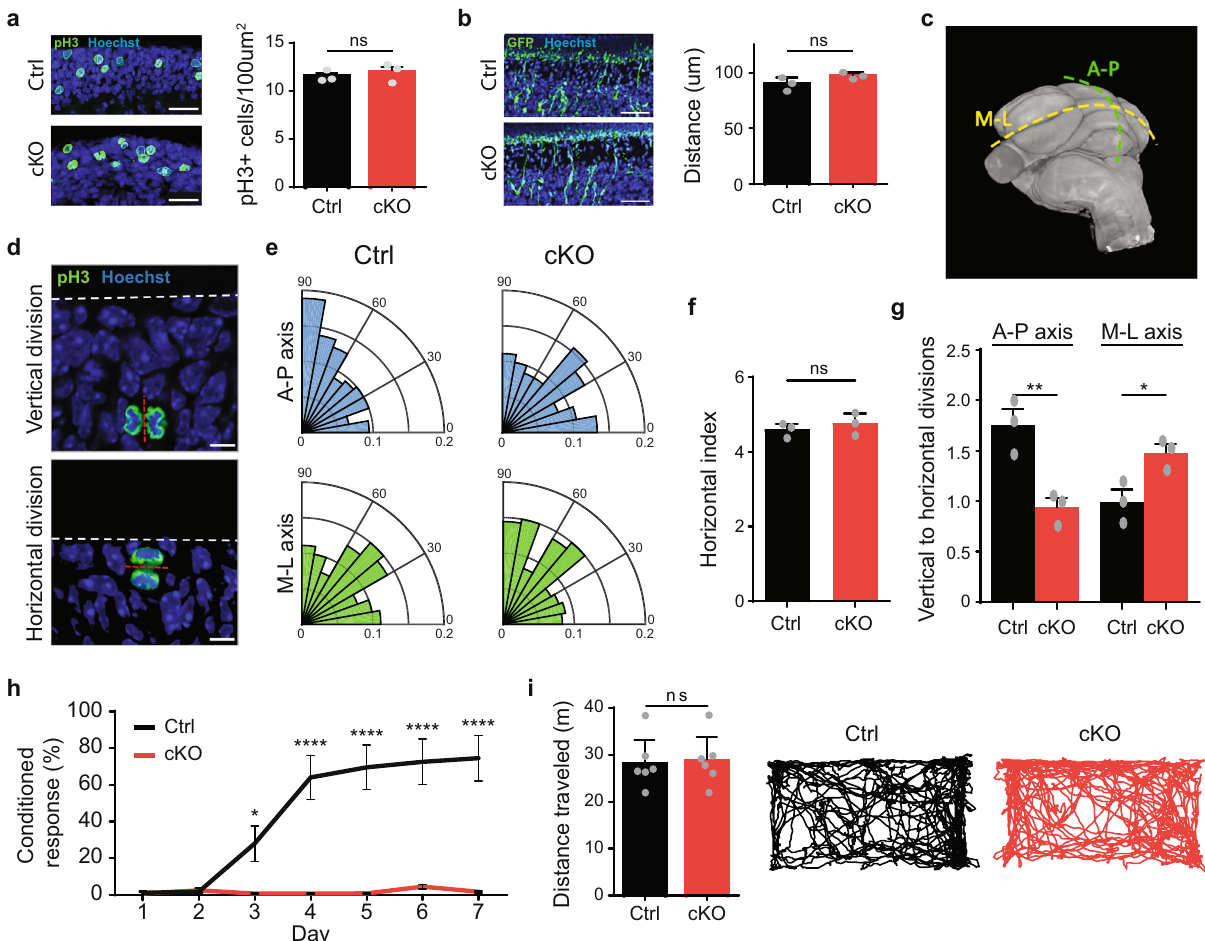
Fig. 5 CHD7 regulates the preferred axis of division for GCPs. a Immunohistochemistry analysis of Ctrl and cKO mice ( n = 3 for each condition) with antibodies recognizing phosphorylated histone H3 (pH3), a marker of dividing cells. Dividing cells were counted in the entirety of the region anterior to the primary fi ssure of the cerebellum (lobules I – V), referred to in shorthand as the anterior cerebellum. A representative image of the external granule layer is shown (left). Bar graphs (right) show mean pH3 positive cells per 100 µ m 2 ± s.e.m. ns = non-signi fi cant. Paired two-sided t -test. Scale bar: 25 µ m. b P6 mouse pups were electroporated ( n = 3 for each condition) with the GFP expression plasmid and killed 48 h later. Cerebella were removed, sectioned, and subjected to immunohistochemistry with antibodies recognizing GFP. Bar graphs show mean distance from EGL ± s.e.m. ns = non-signi fi cant. Paired two- sided t -test. Scale bar: 25 µ m. c Image of P56 cerebellum obtained via nano CT scan (left) showing anterior – posterior axis (A – P) in green and medial – lateral axis (M – L) in yellow. d Immunohistochemistry analysis of axis of division of granule cell precursors, identi fi ed via pH3 staining in green. Dashed red line indicates the plane of division; dashed white line indicates the pial surface. Example of a granule cell precursor undergoing a vertical (top) and horizontal (bottom) division. Experiment was repeated three times for each condition. Scale bar: 5 µ m. e Rose plot showing the distribution of axis of division angles (angle between pial surface and plane of division) for P3 Ctrl and cKO mice in A – P (top, blue) and M – L (bottom, green) axes. 180 cells (60 from each mouse, n = 3 for each condition) were analyzed for each rose plot. f Bar graph showing mean number of horizontal division per 100 µ m 2 ± s.e.m. ( n = 3 for each condition). ns = non-signi fi cant. Paired two-sided t -test. g Bar graph showing mean ratio of vertical to horizontal division ± s.e.m. for Ctrl and cKO mice in both A – P and M – L axes ( n = 3 for each condition). * p = 0.0068 (AP), p = 0.0256 (ML) Paired two-sided t -test. h Cerebellar-dependent eye-blink conditioning learning paradigm was performed on CHD7 Ctrl and cKO ( n = 7 and n = 9, respectively) mice. Percent conditioned response (CR) is shown as mean ± SEM for each session day. ∗∗∗∗ p < 10 − 4 , ∗ p < 0.05 two-sided repeated-measures ANOVA, Sidak ’ s multiple comparison test. i Open- fi eld assay was performed on CHD7 Ctrl and cKO mice ( n = 6 for each) to assess general locomotor activity. Two-sided t -test; ns, not signi fi cant.